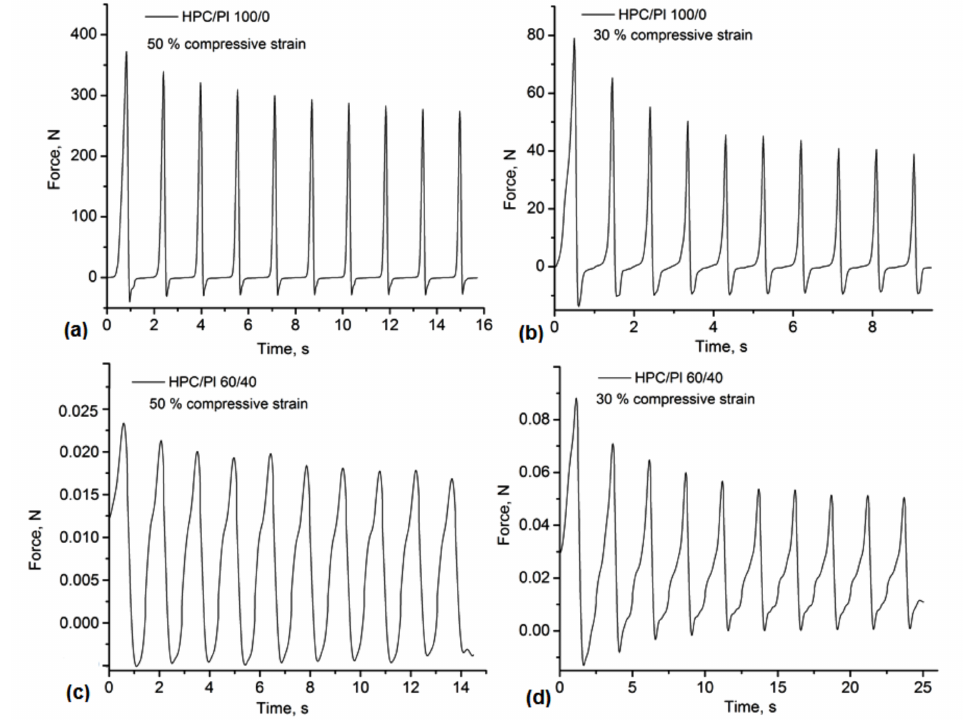
Figure 6. Compression tests of the monoliths under 30% and 50% compressive strains: ( a ) HPC/Pl 100/0—50% strain; ( b ) HPC/Pl 100/0—30% strain; ( c ) HPC/Pl 60/40—50% strain; ( d ) HPC/Pl 60/40—30%